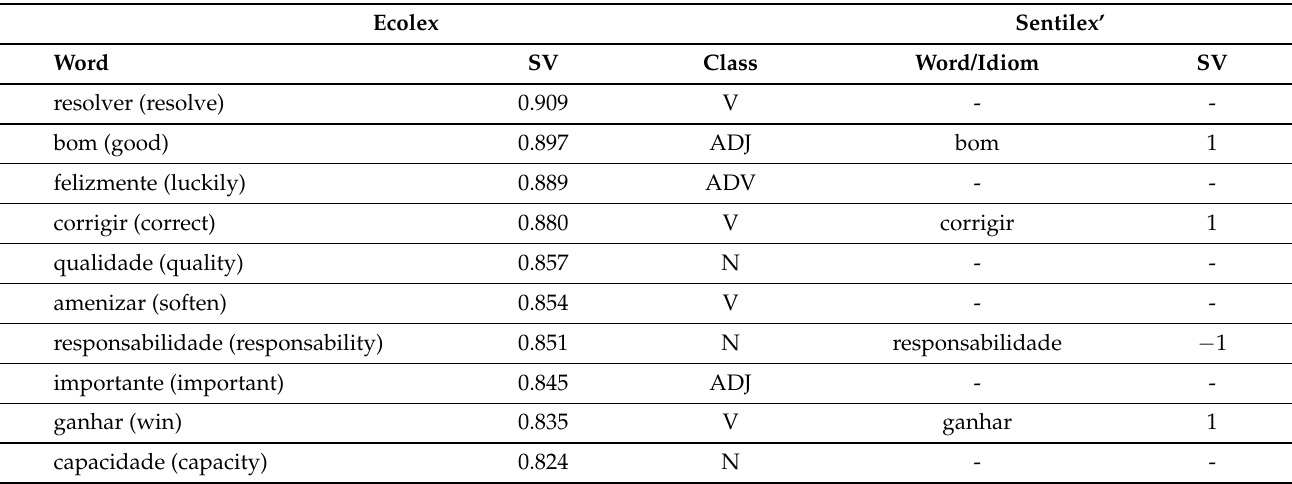
Table 2. Examples of some positive lexicon entries in Ecolex and Sentilex’.